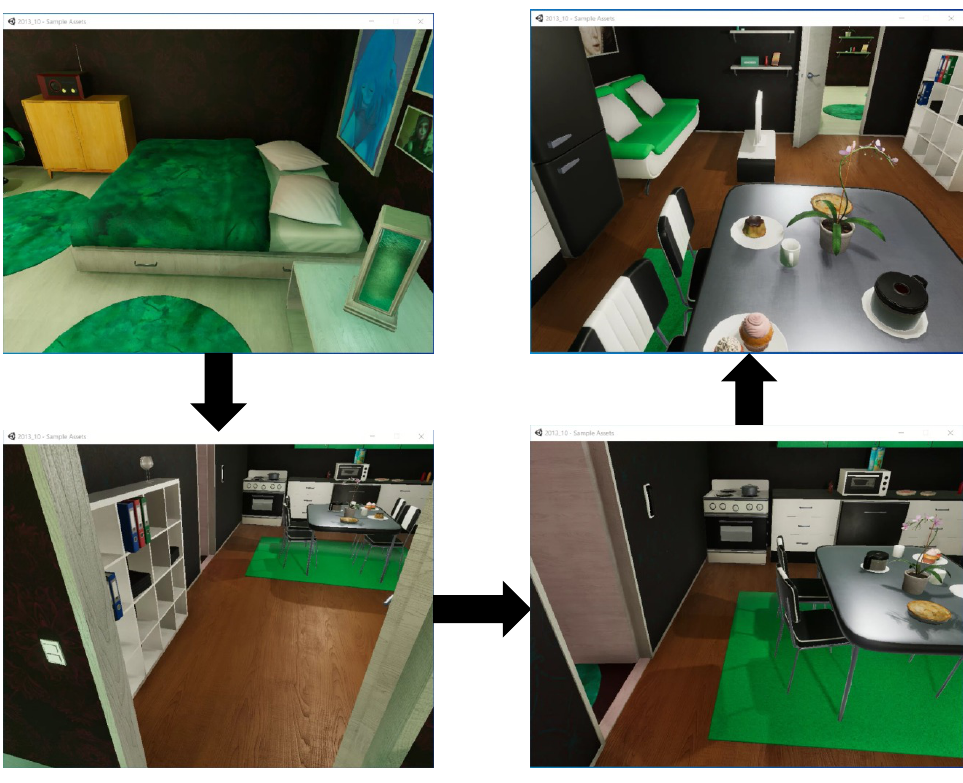
Figure 15. Result of